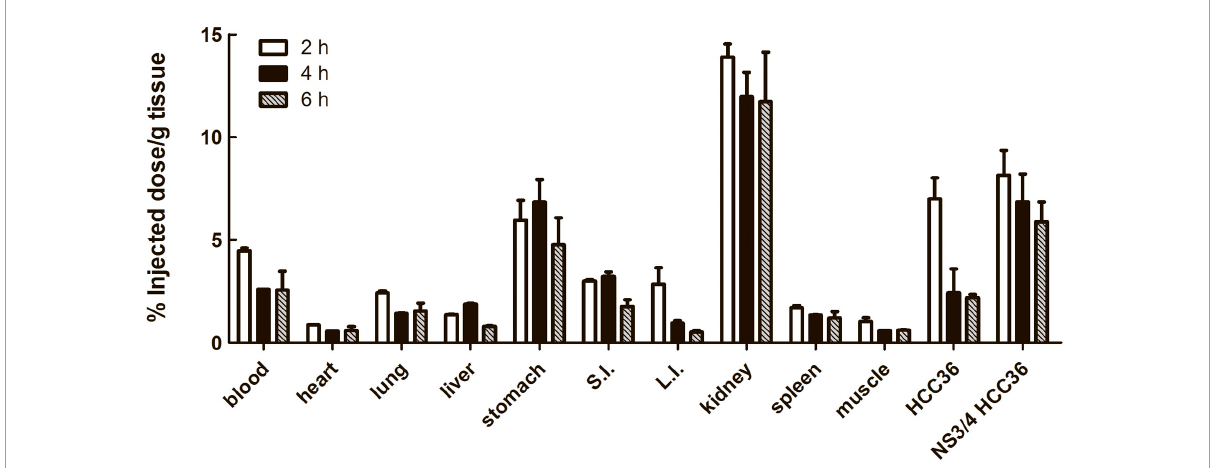
FIGURE6 Biodistribution of TAT- (cid:49) NS3/4A- 124 I-FITC in xenograft mice. Mice bearing established NS3/4A-HCC36 and HCC36 tumors were injected with 3,700 kBq of TAT- (cid:49) NS3/4A- 124 I-FITC. Selected organs and tumors were removed from the mice after 2 (white column), 4 (black column), and 6 (gray column) h. The radioactivity of individual organs was measured using a gamma-counter and normalized for sample weights. The biodistribution of TAT- (cid:49) NS3/4A- 124 I-FITC in selected organs was expressed as percentage injected dose/g tissue. Data represent mean ± SEM.